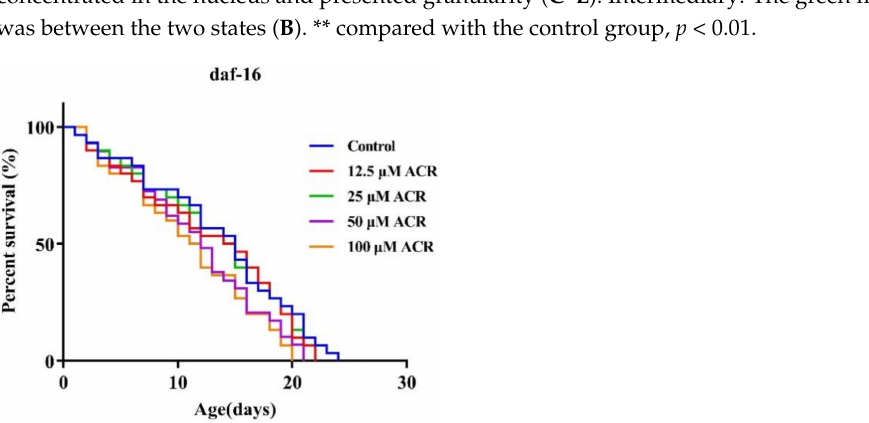
Figure 8. Effect of ACR exposure (12.5, 25, 50, and 100 µ M for 48 h) on lifespan of daf-16 mutant ( n ≥ 30 worms per